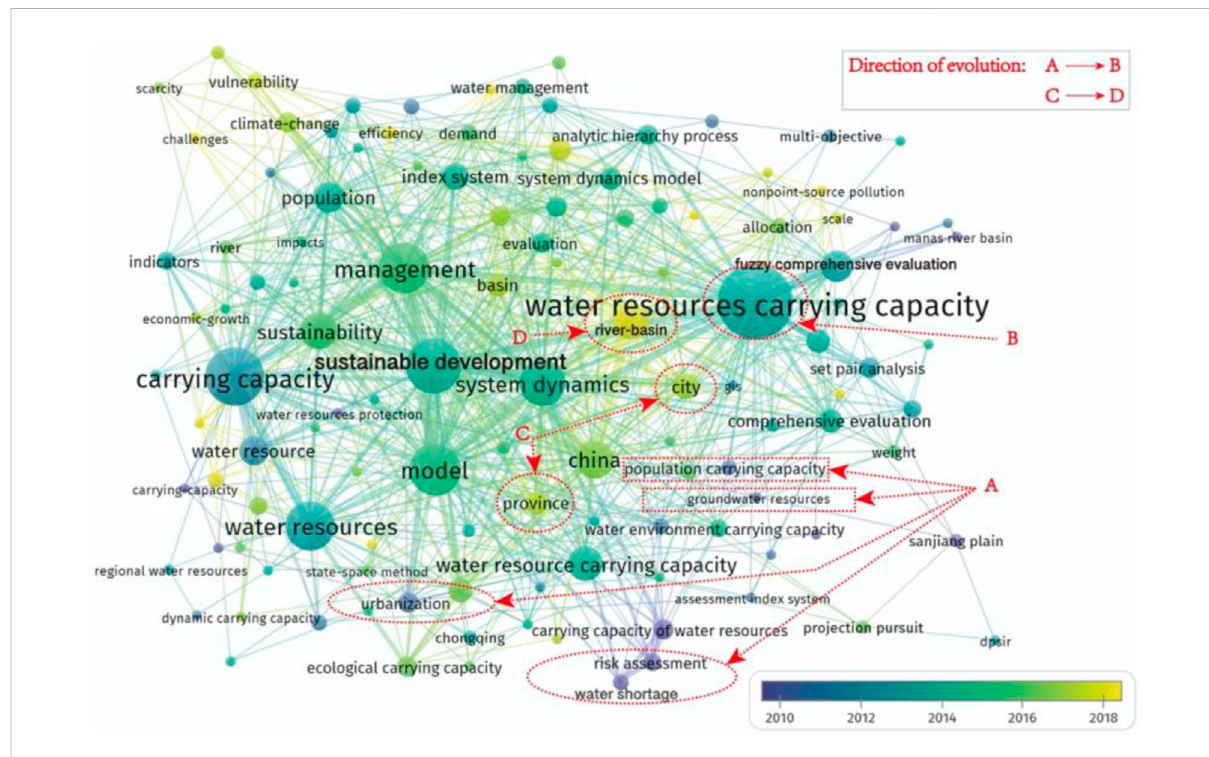
FIGURE 10 Keyword evolution